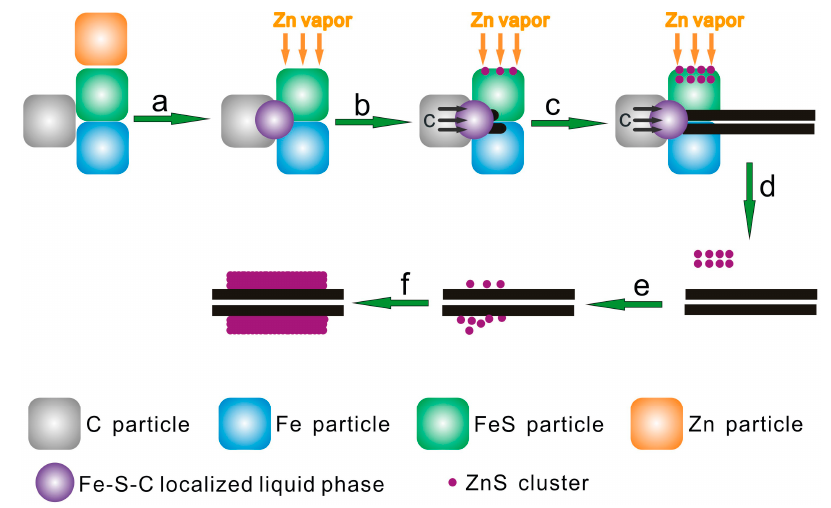
Figure 4. Schematic illustration of the formation process of the SWCNT–ZnS nanocables.